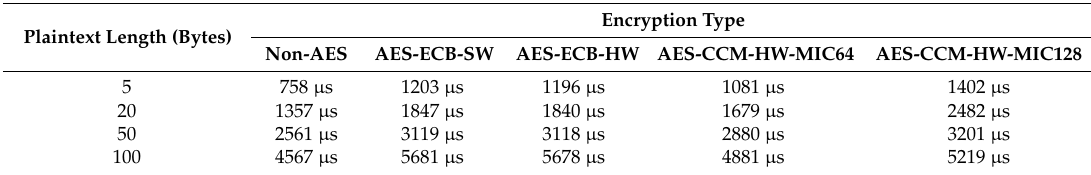
Table 4. Average transmission times of different encryption types in different payload lengths.